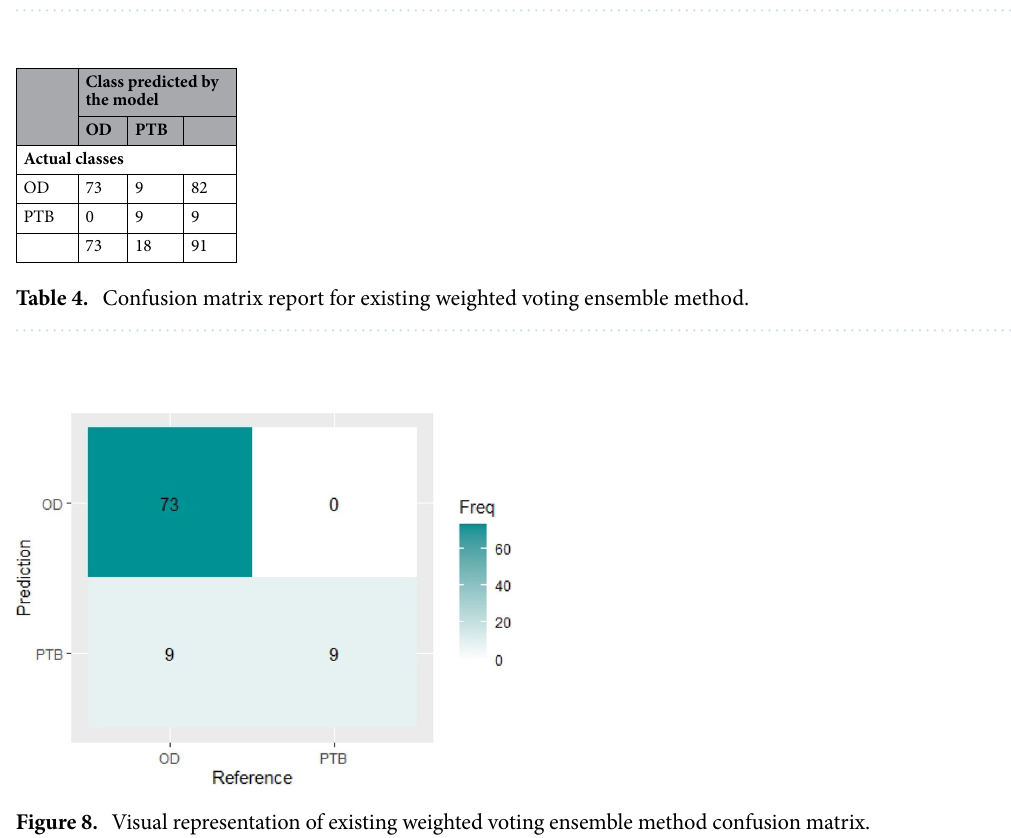
Figure 7. Visual representation of NB classifier’s confusion matrix.